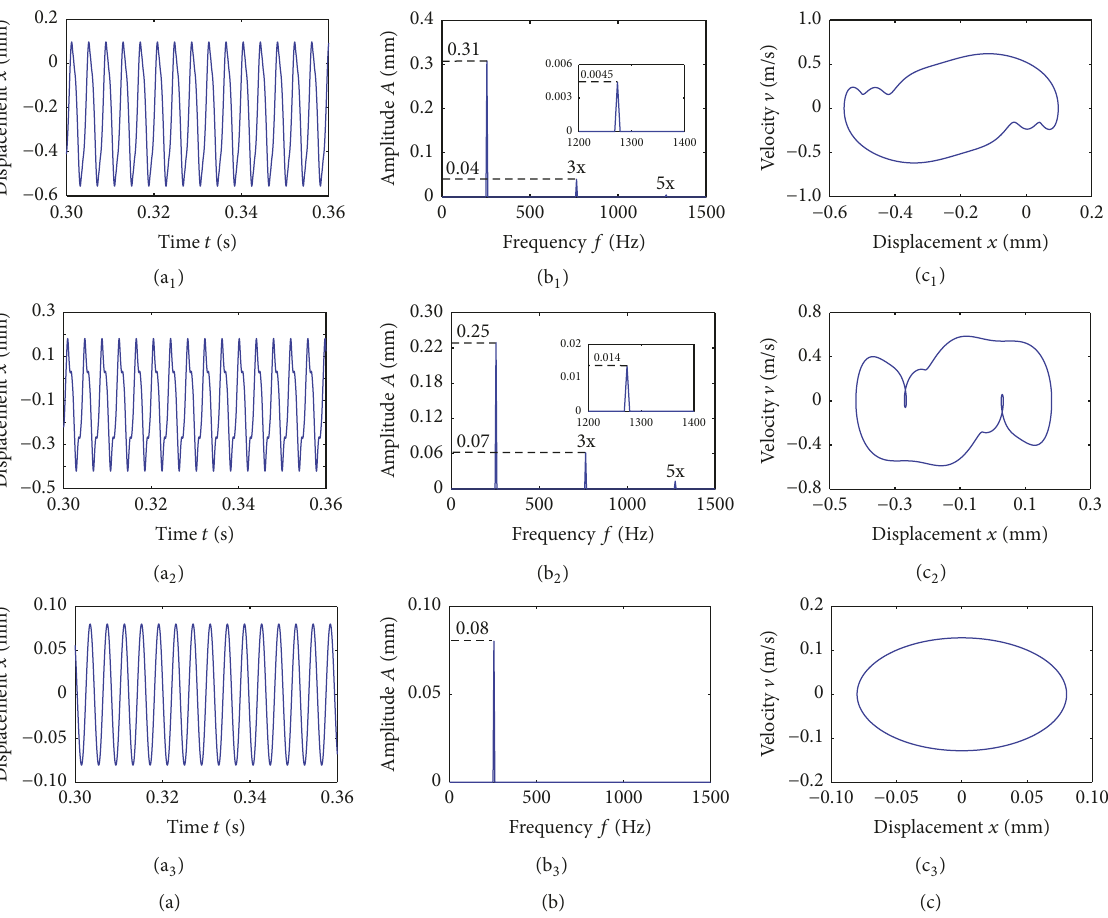
Figure 4: The responses of blade-root at different rotating speeds ((a) is the time-domain response, (b) is the frequency spectrum, and (c) is the phase